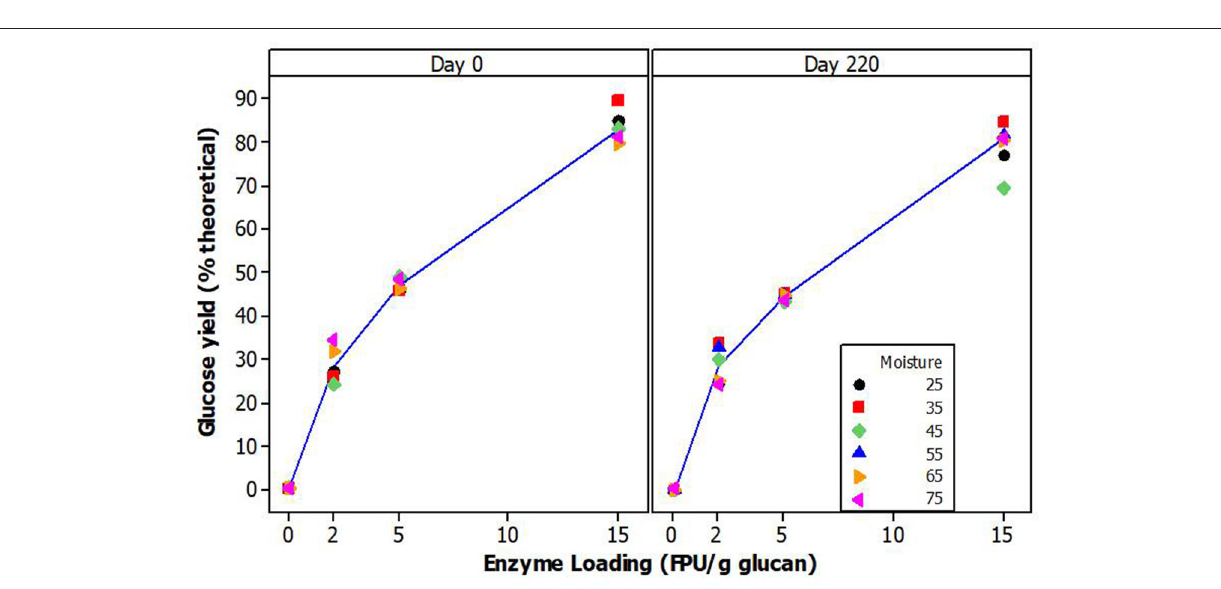
removal there was no significant difference across moisture for day 0 samples ( p = 0.545). Glucan removal at day 220